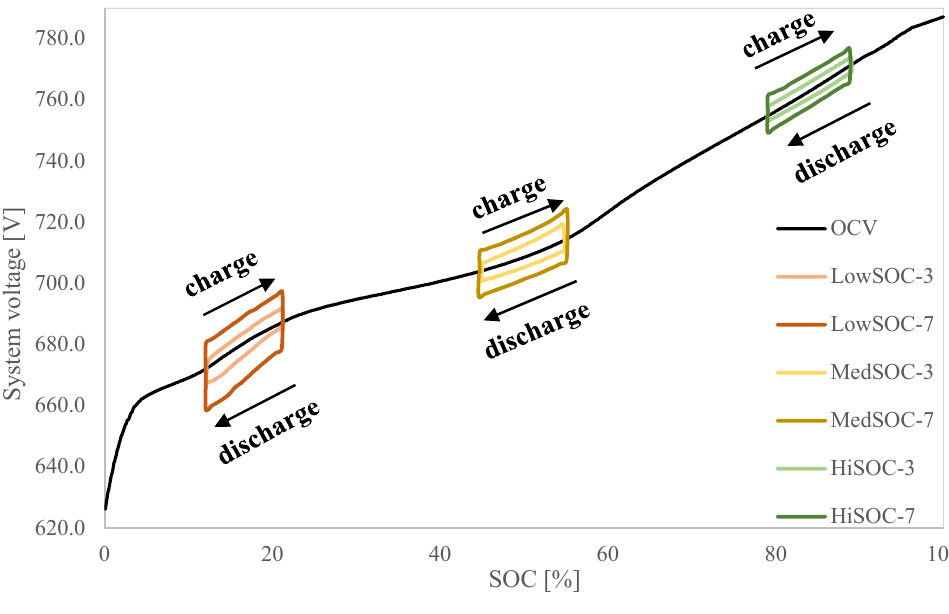
Figure 4. Voltage diagram for test Set 2.